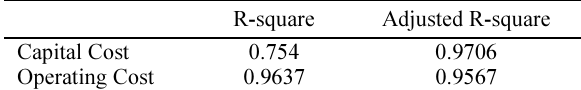
Table 7. MVLR coefficients of determination